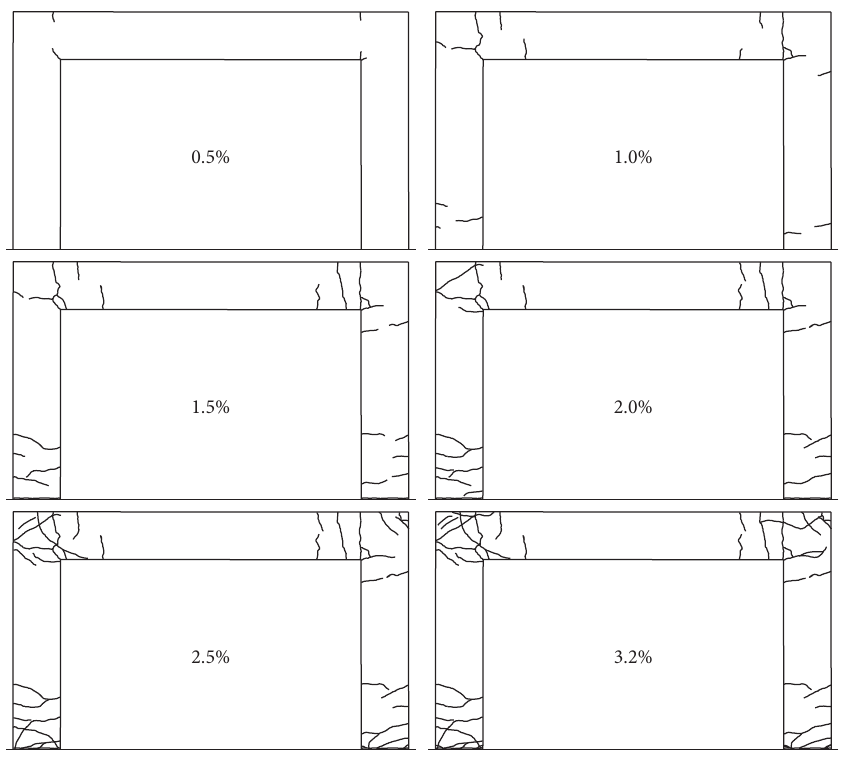
Figure 7: Approximate crack damage patterns for 0.5–3.2% drift ratios.